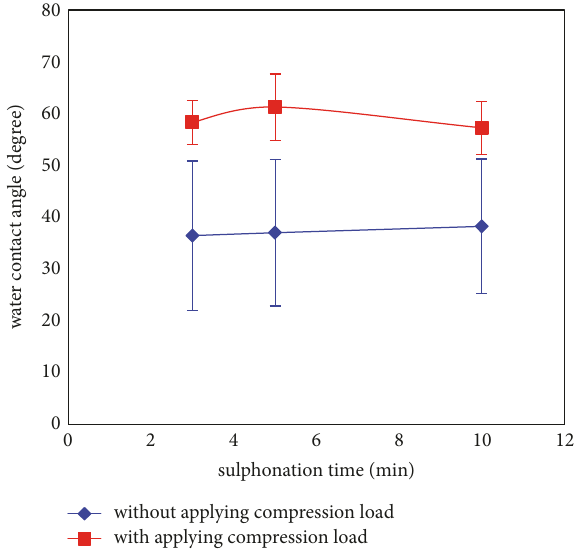
Figure 8: The effect of the compression load on the water contact angle of the samples with different sulphonation times